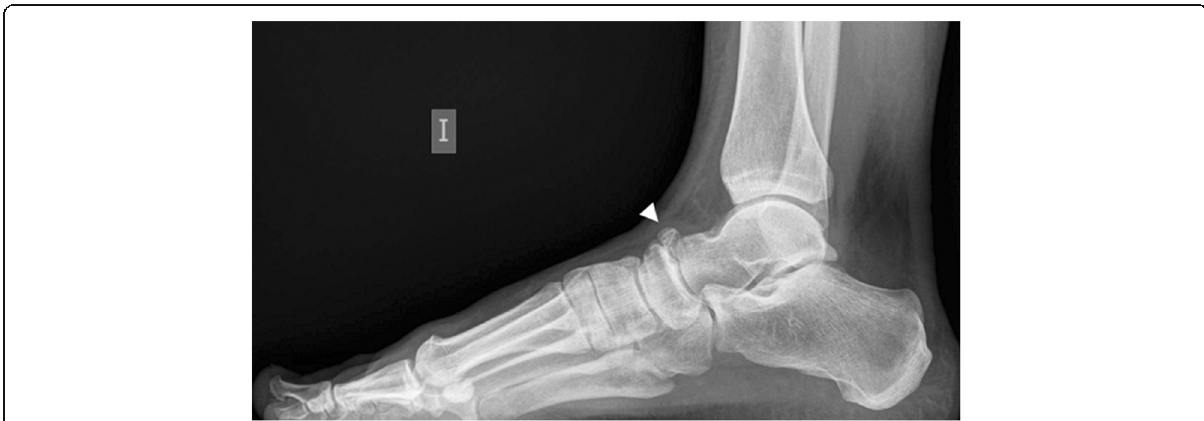
Fig. 6 Os supranaviculare. Example of an incidental finding of an os supranaviculare (arrowhead) on a 39-year-old woman, referred with the suspicion of sesamoiditis